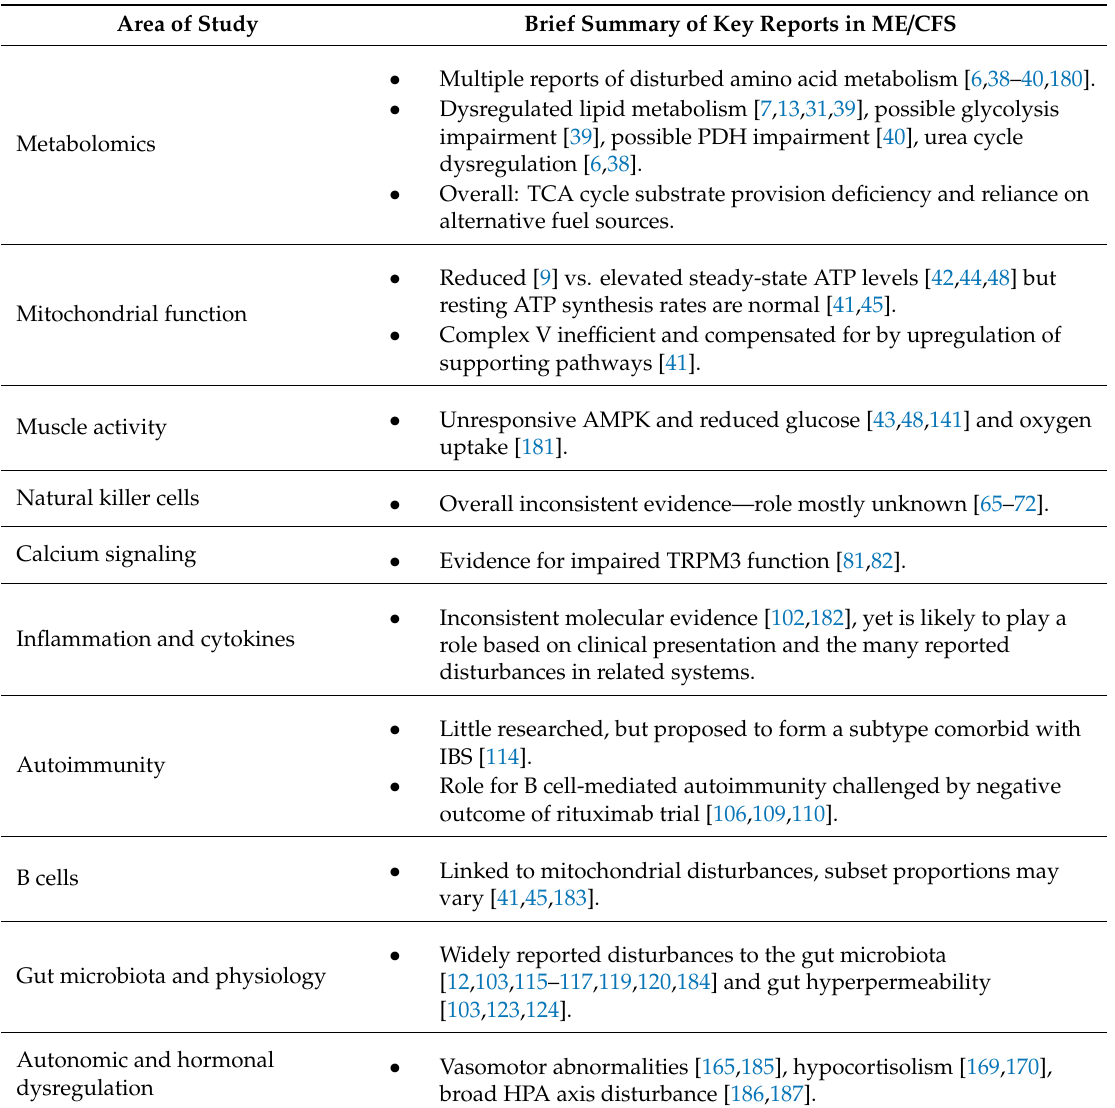
Table 1. Brief summary of relevant reports contributing towards the biomedical basis of ME /